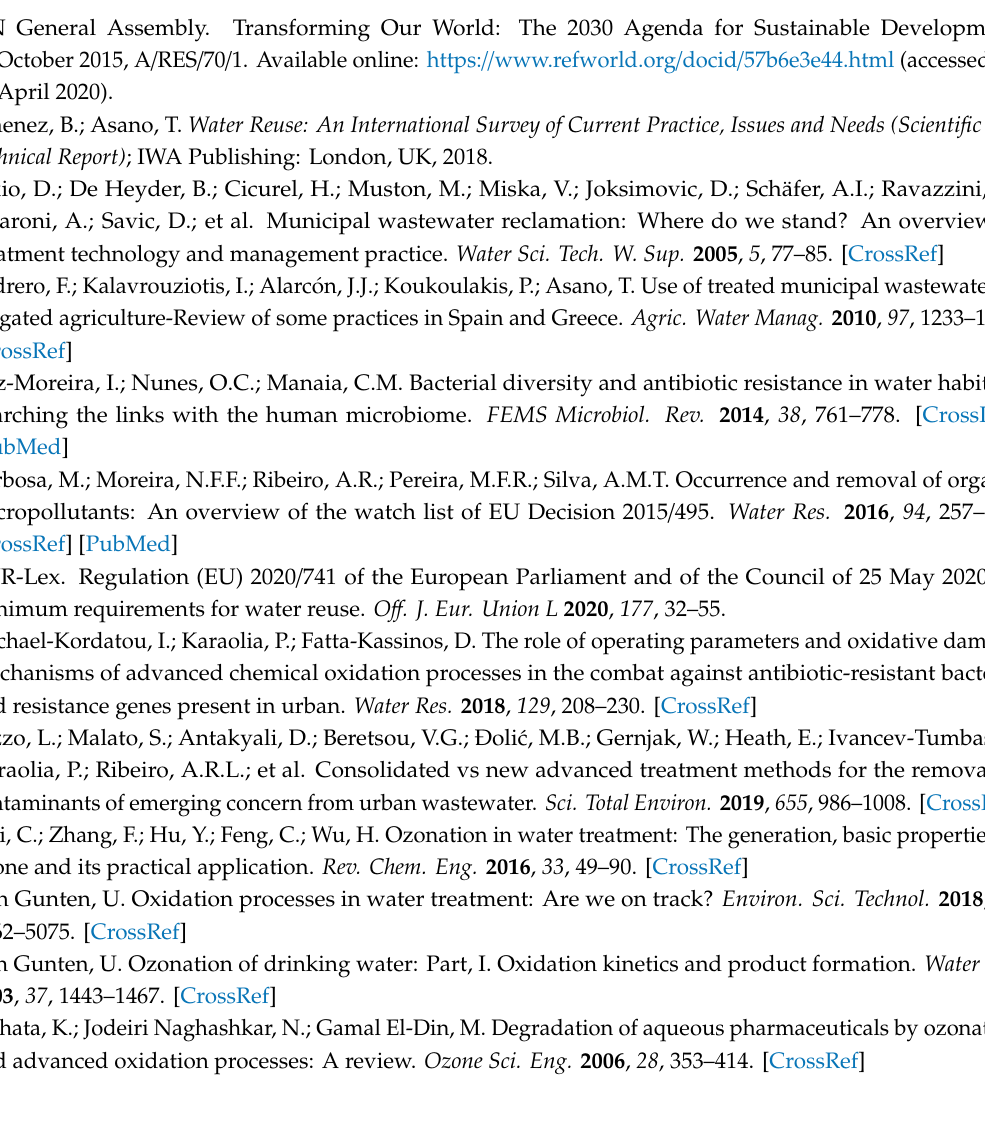
Table S1: Quantitative PCR conditions used in the present study for absolute gene quantification in all WW, TWW 0 , and TWW 7